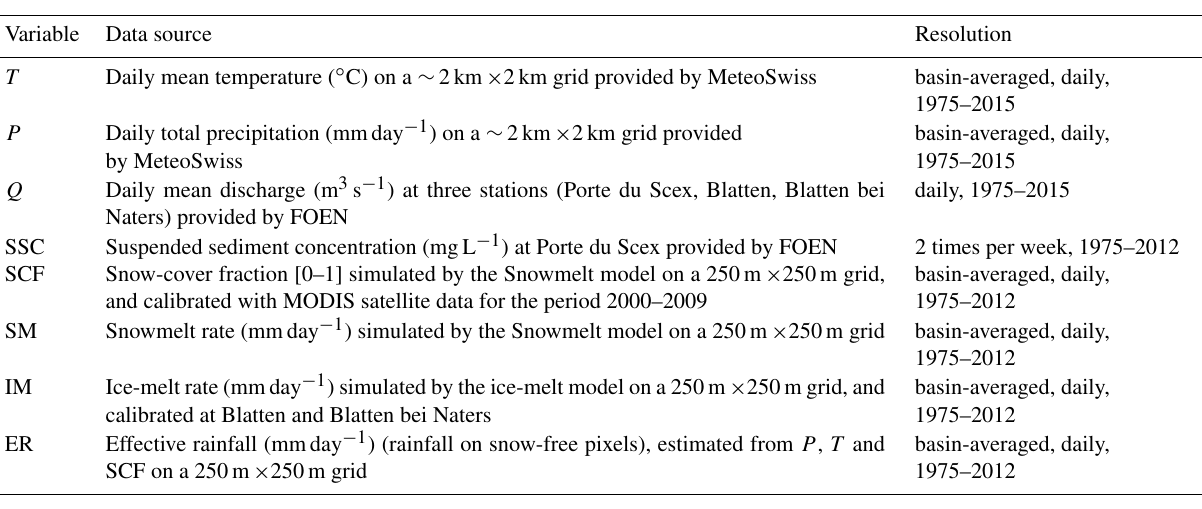
Table 1. List of the variables analysed: observed SSC and hydroclimatic variables originating from measurements ( Q ), spatial interpolation of measurements ( T , P ), simulations of the snow and ice-melt model (SCF, SM, IM), or a combination thereof (ER). Information on the source and the spatial and temporal resolution are reported for each